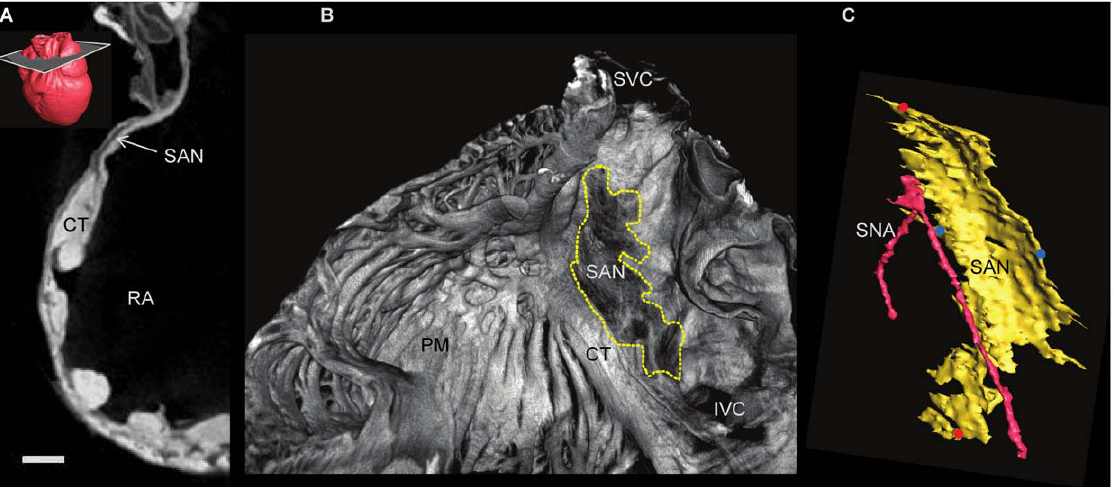
Figure 3. The atrioventricular conduction axis in rabbit. Longitudinal micro-CT images showing the penetrating bundle (A,D) and His bundle (B,E) in a rabbit heart stained with 7.5% I 2 KI for 3 days. Segmented 3D surfaces of atrioventricular conduction axis, showing the anteriorly positioned His bundle (C) and its lateral aspect (F). Distance between red dots- 1.1 mm, green dots- 7.8 mm. AOV- aortic valve, HB- His bundle, IVC- interventricular septum, LBB- left bundle branch, LV- left ventricle, PB- penetrating bundle, RBB- right bundle branch. (Scale bar represents 1